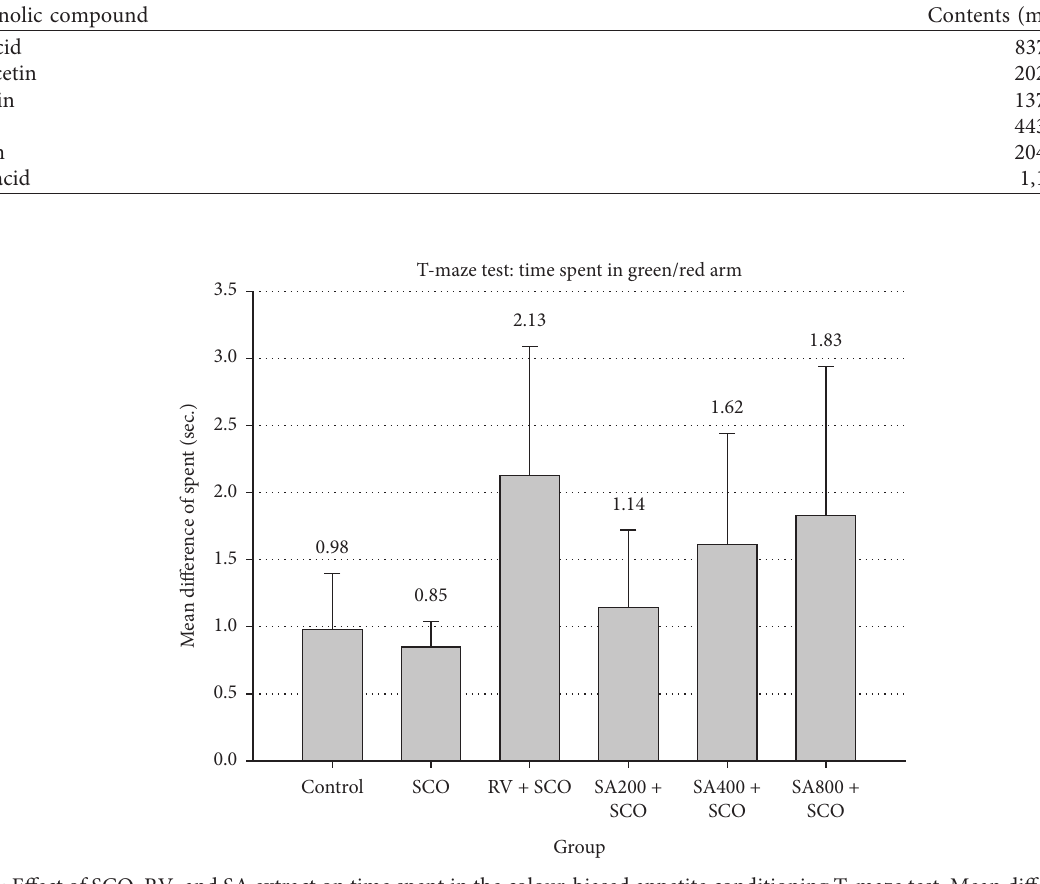
Figure 2: Effect of SCO, RV, and SA extract on time spent in the colour-biased appetite conditioning T-maze test. Mean difference of time spent in green arm and red arm expressed as mean ± SEM. Zebrafish that received RV +SCO, SA200 +SCO, SA400+ SCO, and SA800+SCO showed mean difference of time spent at more than 1 as 2.13 ± 0.96, 1.14 ± 0.58, 1.62 ± 0.82, and 1.83 ± 1.11,